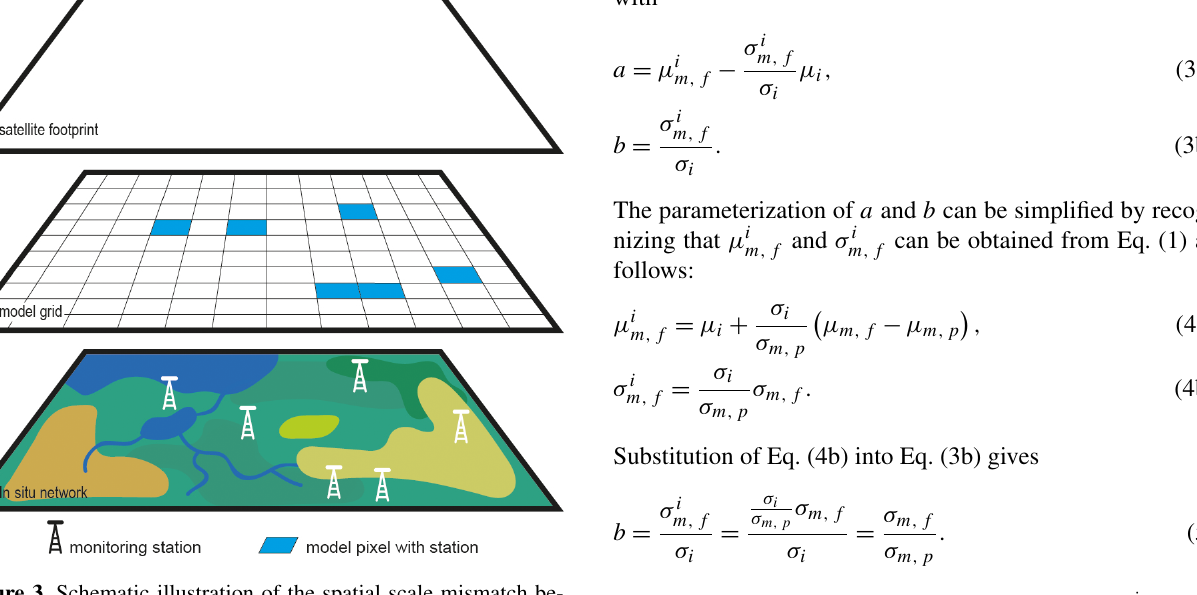
Figure 3. Schematic illustration of the spatial scale mismatch be- tween in situ monitoring stations, hydrological model grid, and SMAP reference pixel (satellite